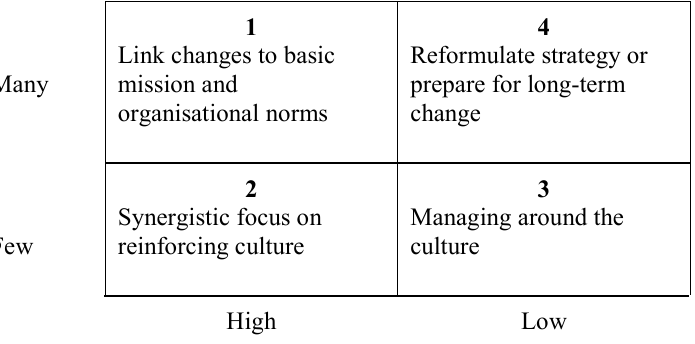
Figure 1: Framework for managing the strategy-culture relationship